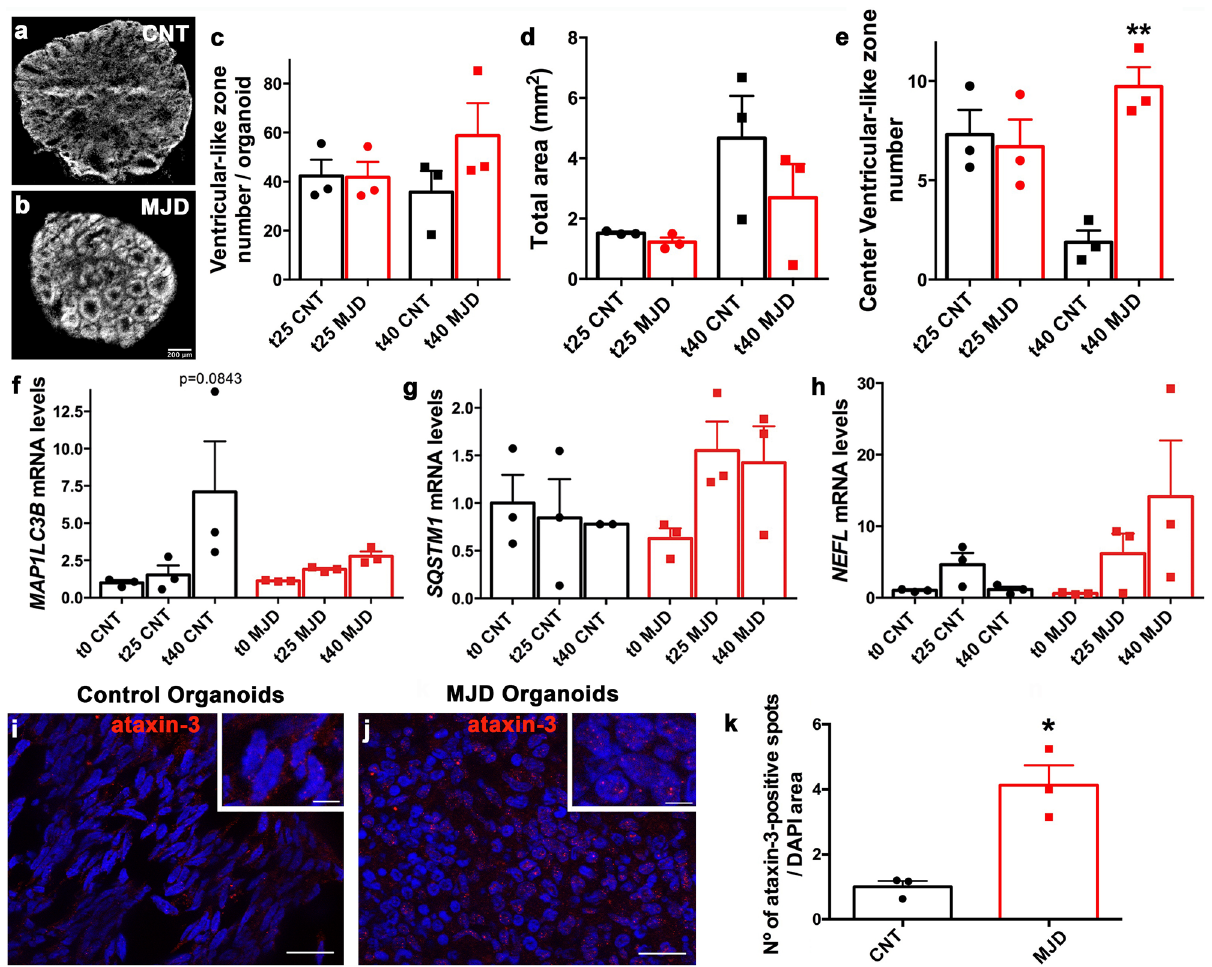
Figure 4. Neuropathology hallmarks in MJD brain organoids evaluation. (a–e) Control and MJD brain organoids derived from control and MJD iPSC, respectively, present ventricular-like zones assessed by nuclear DNA labeling with DAPI. (a,b) Representative images illustrating brain organoids´ ventricular-like zones in (a) control and (b) MJD organoids; scale bar: 200 μm. Quantification of (c) ventricular-like zones number per organoid, (d) organoids area, and (e) central ventricular-like zones number (in 25% of the center of the organoids) of control and MJD organoids with 25 and 40 days, t25 and t40 respectively. Autophagy markers (f) MAP1LC3B (LC3B) and (g) SQSTM1 (P62) and neurodegeneration marker (h) NEFL (NfL) mRNA levels evaluation. Control and MJD organoids collected at different time points (day 0, 25, and 40; t0, t25, and t40 respectively) were evaluated for the mRNA levels through RT-qPCR, and normalized for t0 CNT. MJD organoids presented a tendency for lower MAP1LC3B and higher SQSTM1 mRNA levels at day 40, as compared with control organoids. Data are expressed as mean ± SEM (n: 3 independent experiments), **p < 0.01 ( c–e : comparison established between CNT and MJD at the same time point, f–h : comparison established with the correspondent t0), One-way ANOVA followed by Tukey posttest. (i,j) Representative immunofluorescence pictures of control (CNT) and MJD brain organoids with 40 days stained for human ataxin-3, (red) showing ataxin-3-positive protein spots/aggregates. Upper inserts: higher magnification image showing ataxin-3- positive spots/aggregates (red) in DAPI-positive cell nucleus (blue). Representative images of 3 independent experiments, scale bars: 20 μm and 5 μm in upper inserts. ( k) Quantification of ataxin-3-positive spots in cell nucleus (DAPI) of control and MJD brain organoids at day 40 demonstrated significantly higher number of ataxin-3-positive spots in MJD organoids, as compared with control organoids. Data are expressed as mean ± SEM (n: 3 independent experiments), *p < 0.05, Unpaired t test with Welch’s MJD‑associated neuropathology hallmarks in MJD whole‑brain organoids. Immunohisto- chemistry of human brain organoids revealed the presence of ventricular-like zones, which are associated with primates’ brain development 10,13,14 . Morphologically, organoids maturation can be estimated by the number of ventricular-like zones and their regionalization, for instance, a higher number of ventricular-like zones is an indication of less mature organoids 23 . Therefore, in order to understand whether the MJD organoids present differences in maturation, ventricular-like zones number and organoids size were assessed (Fig. 4a–e). Although no significant differences were found in the ventricular-like zones number per area (Fig. 4c) or in the organoids